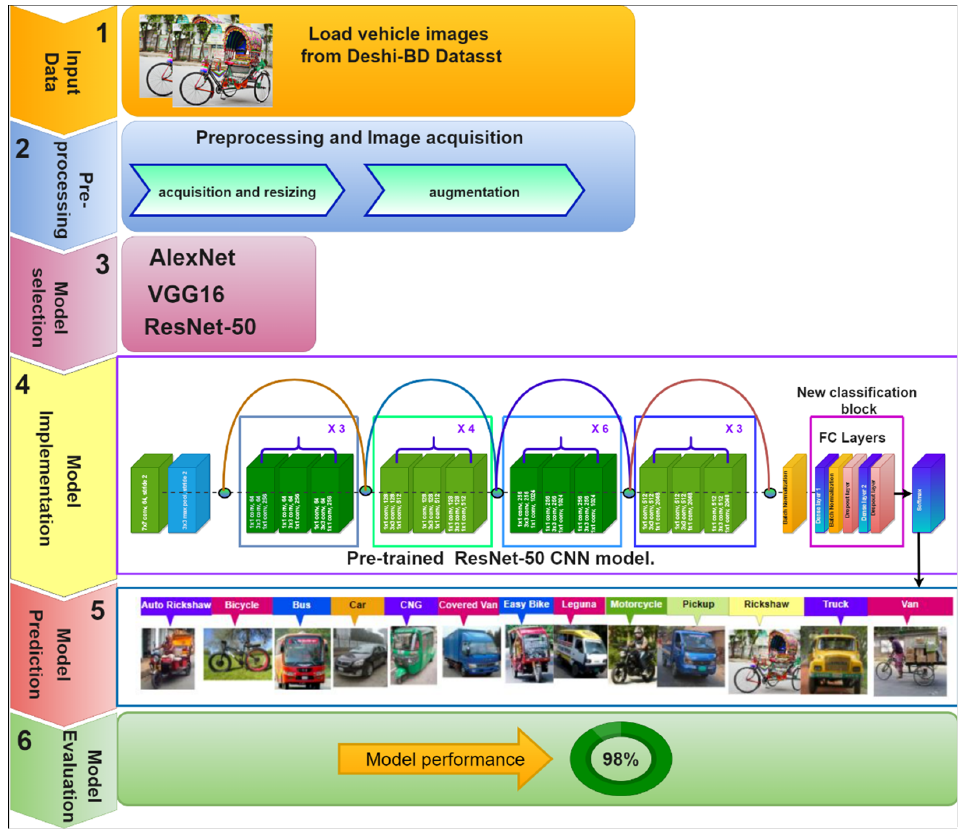
Figure 7. An overview of the proposed model outline. The Deshi-BD vehicle dataset was used to train ResNet-50 pre-trained architecture. A dropout layer is present at the bottom of the model to solve the vanishing gradient problem. A new, fully connected layer was added based on the classification block to conduct thirteen categories of native vehicle classifications, where each unit in the last layer was linked to the thirteen-class output probability using the softmax function. To confirm that these newly added layers learn greater-level feature characteristics from the dataset, we enlarged their learning rate in comparison to the prior layers’ learning rate. In addition, only the specific newly added layers included in the base model were trained, with the early convolutional layers frozen. The main concept behind freezing these layers was to accelerate convergence while avoiding the gradient outbreak throughout the training phase. After removing texture characteristics, classification was performed to compare the projected class to the real class. Over the training procedure, the network’s computation costs decreased, while the total trainable parameters of the modified CNN model also reduced. The architecture of our proposed ResNet-50 pre-trained CNN model is shown in Table